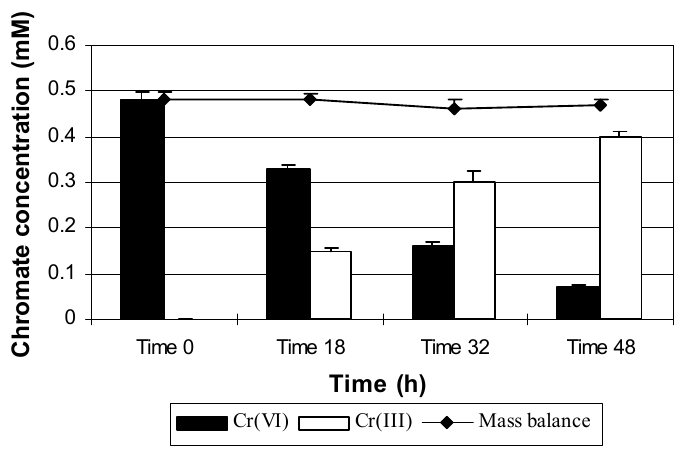
FIGURE 5. Chromium (VI) reduction by S. marcescens immobilized on activated carbon with initial 0.5 mM potassium chromate at 30”C.